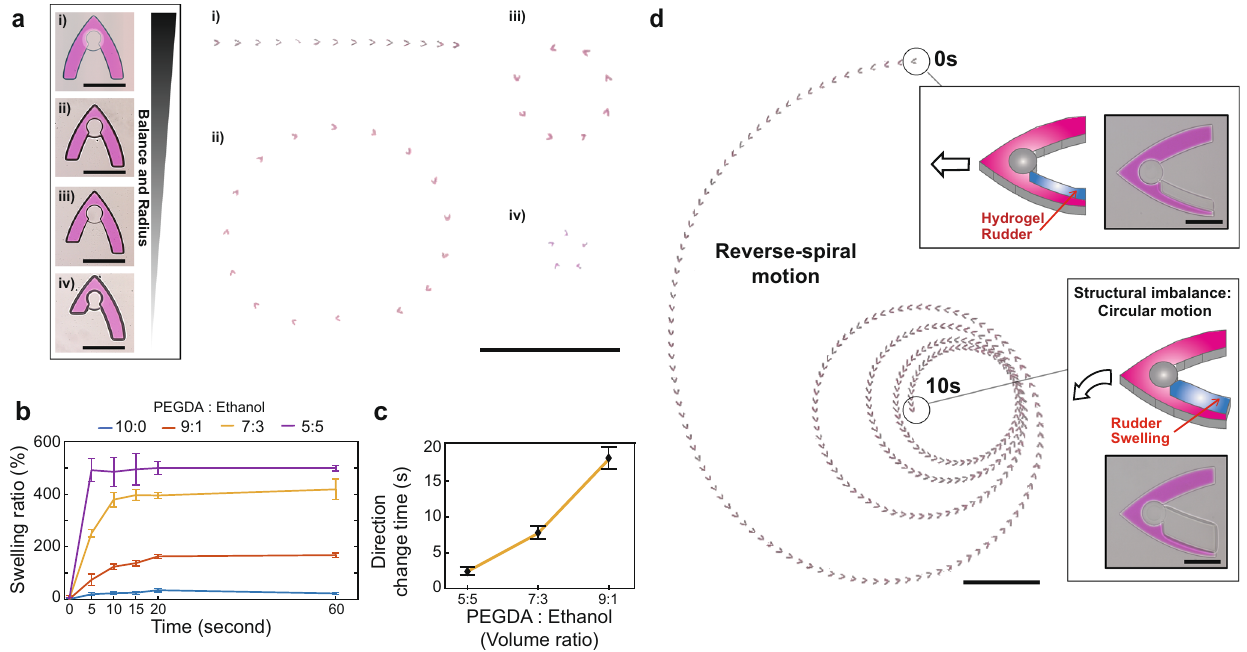
Fig. 3 Hydrogel rudders enable time-dependent motion change of microswimmers. a By controlling the size difference between each wing of rocket-like swimmers, we were able to program swimmers motion from linear to circular with smaller diameters. In zoom-out pictures, the fi rst circular motion of swimmers after it touches the water surface was displayed. Scale bar represents 500 μ m (black boxes) and 1 cm (zoom-out pictures). b Swelling ratios of the hydrogel rudder (compared to the initial volume of fully dried gel) according to volume ratios of PEGDA to ethanol in the fabrication solution ( n = 15). The swelling saturation time decreased as the ethanol ratio increased. The initial size of the hydrogel is 1.25 × 10 6 µ m 3 . c The time for motion change from circular to linear (the microswimmer in Fig. 1d) was programmed by changing the volume ratio of PEGDA to ethanol ( n = 10). The size of the rudder is selected such that the swimmer is balanced when it fully swells. The error bars represent s.d. d Time-dependent motion change from linear to circular (reverse-spiral movement). Volume ratio of PEGDA:ethanol for the rudder fabrication was 9:1; scale bar represents 250 µ m (black boxes) and 1 cm (zoom- out